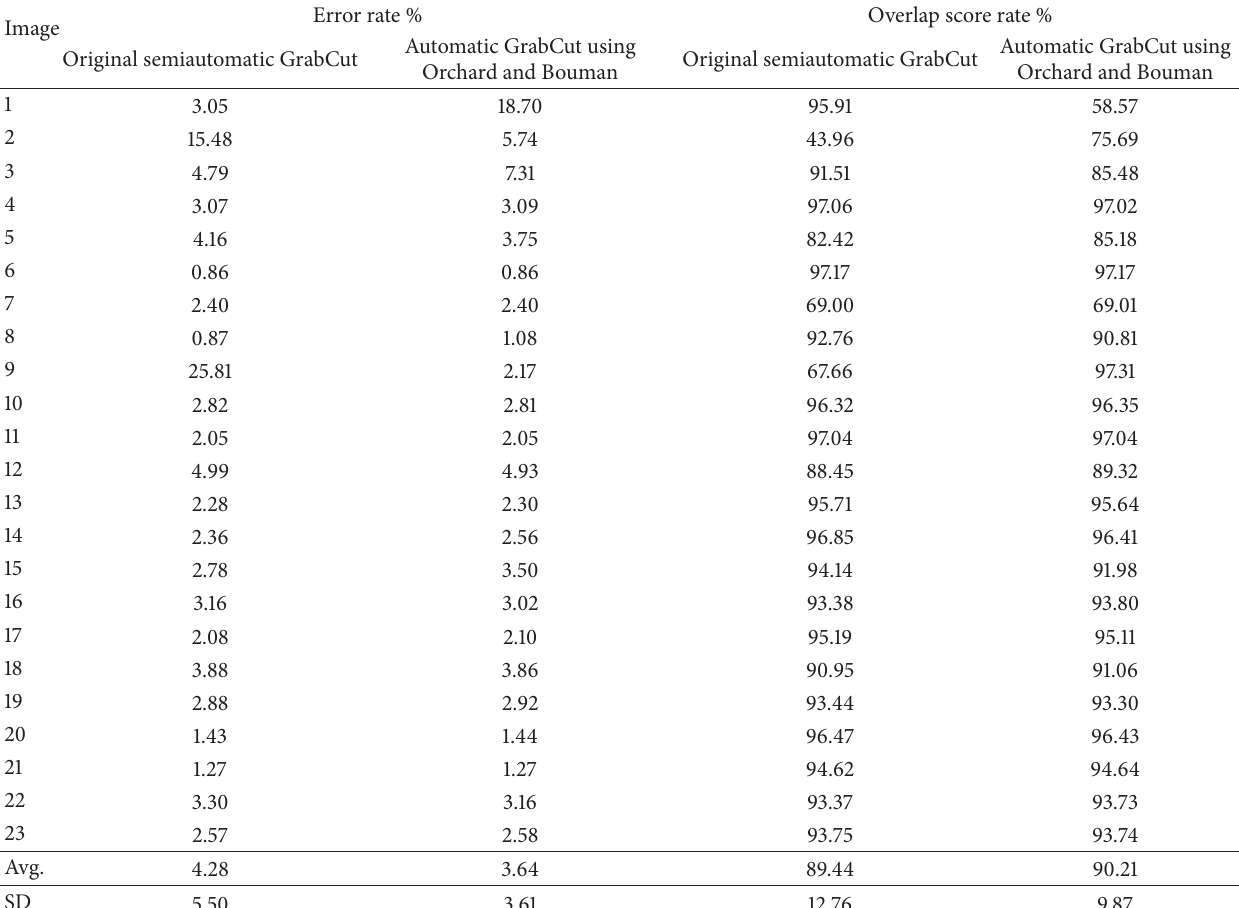
Table 1: Comparisons between the original and automatic